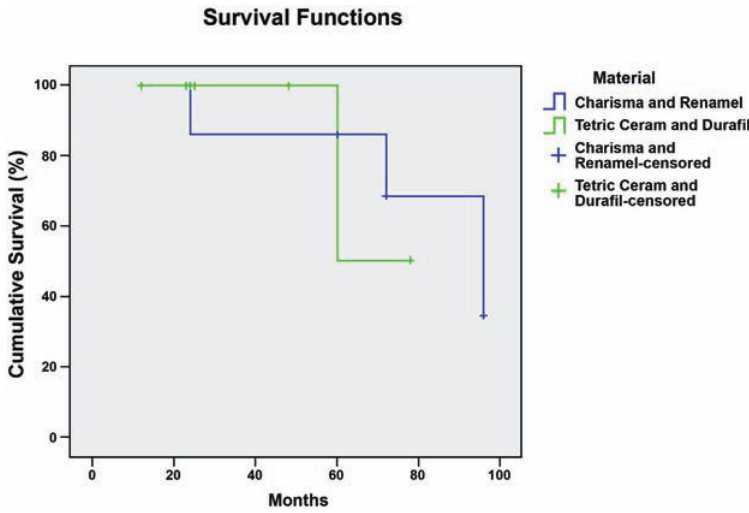
Figure 7- Survival functions of fiber-reinforced fixed partial dentures according to composites combinations. Differences among curves were not statistically significant by Log Rank Test